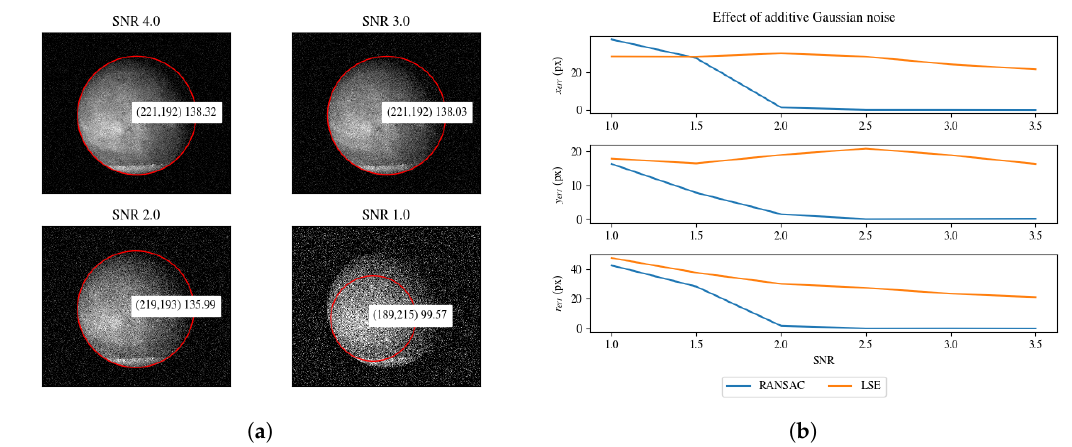
Figure 9. ( a ) Effect on parameter estimation for input image corrupted with additive Gaussian noise. ( b ) Model parameter estimation errors for increasing SNR. The error values x err , y err and r err are computed as the absolute difference between the parameter obtained from an uncorrupted image and the parameter obtained from the corrupted image.